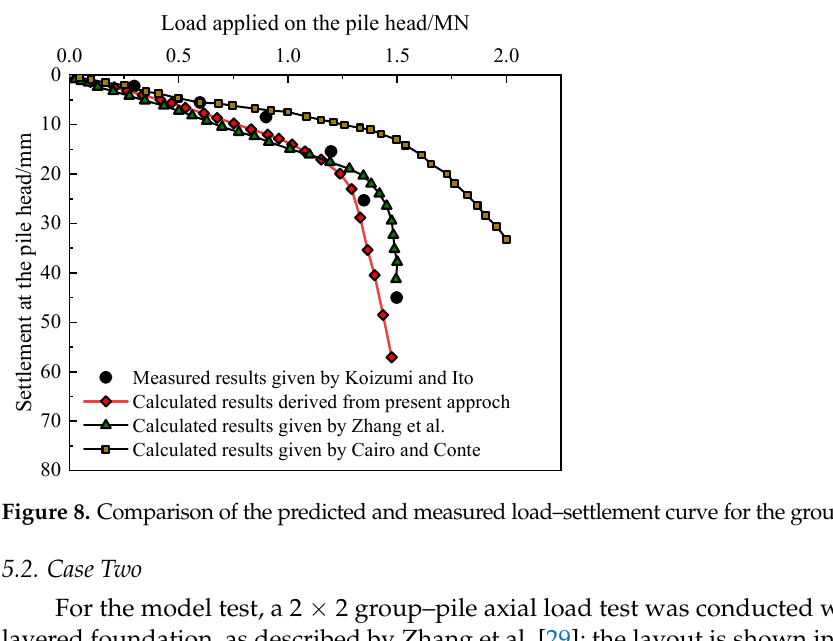
14 of 17 Figure 7. Layout of the pile group and subsoil model. The diameter of the pile is 300 mm, the elastic modulus is 20 GPa, and the buried depth of the pile is 5.5 m. The pile distance is 6 r, which is connected to the pile cap. Dou- ble–layered soil exists on the pile side, the upper layer is sandy silt, the depth is 1.7 m, the friction angle is 23 . 3 ∘ , the control parameter is 𝐵 1 = 200, and the softening ratio is 𝑅 1 = 0.9. The bottom soil is silty clay, the depth is 3.8 m, and the friction angle is 21 . 5 ∘ . The shear strength can be calculated as 30 MPa, the control parameter is 𝐵 2 = 200, and the softening ratio is 𝑅 2 = 0.85, showing that the value of 𝜏 (cid:3033) deduced from the laboratory [2] increases from approximately 25 kPa at the pile head to approximately 40 kPa at the pile tip. The Poisson ratio of the upper soil and bottom layer is 0.5. The failure ratio is 𝑅 (cid:3033) = 0.85 and 𝑅 (cid:3029)(cid:3033) = 0.85. The parameters 𝐴 (cid:3029) and 𝐵 (cid:3029) can be calculated with Equations (16) and (17), taken as 1 . 1 (cid:3400) 10 (cid:2879) 4 and 2 . 67 (cid:3400) 10 (cid:2879) 2 , respectively. According to the loading experiment, the elastic modulus of the pile–side soil can be calculated based on the proposed equation 𝐸 (cid:3046) = 520𝜏 (cid:3033) [2], and the elastic moduli of up- per soil and bottom soil are 12.8 MPa and 15.6 MPa, respectively. Then, the load–settle- ment curve of the pile foundation can be obtained. As shown in Figure 8, when the load is small, the calculated settlement based on the proposed method is similar to that based on the method proposed by Zhang et al. [28] and Cairo and Conte [2]. The calculated settlement is in agreement with the on–site data, which indicate that there is no relative slip between pile and soil (the soil is in an elastic state). With increased load, the pile–side soil is in an elastoplastic state, and slip between